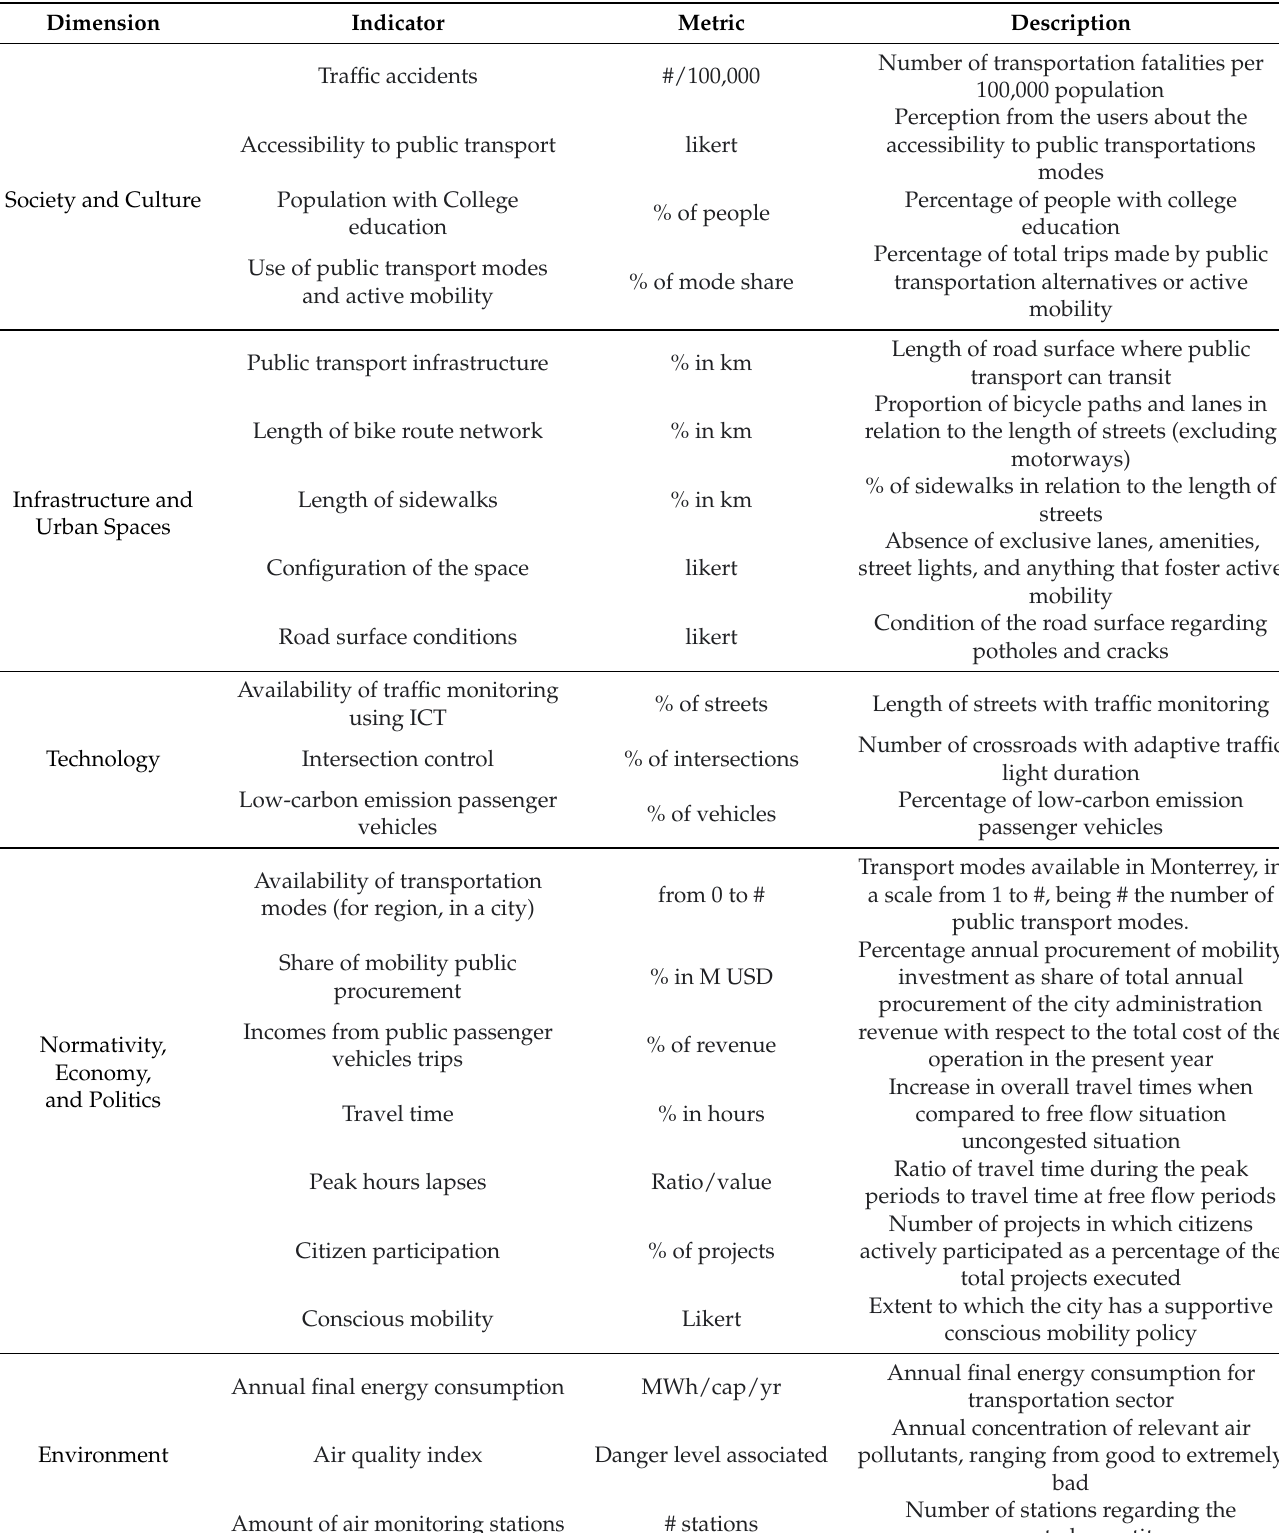
Table 2. Conscious mobility index framework for DistritoTec,